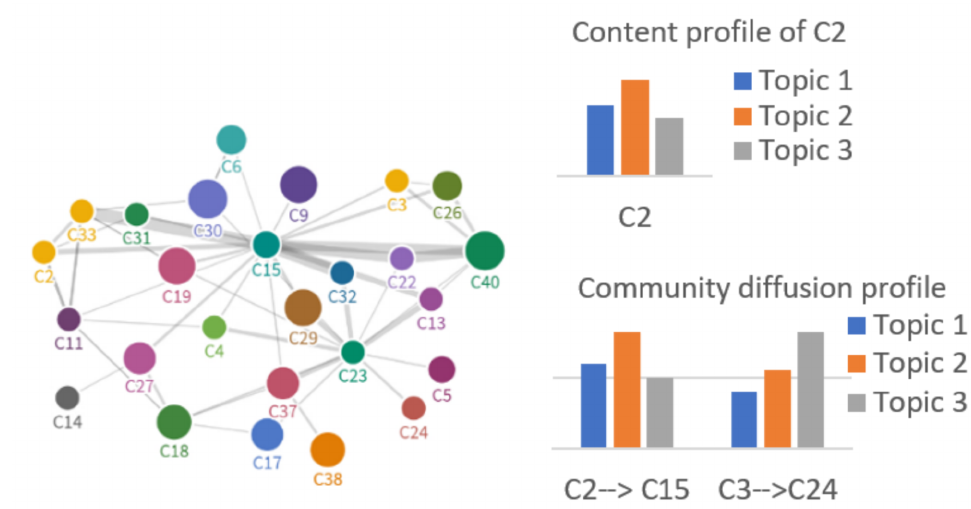
Figure 1. Community content and diffusion profiles